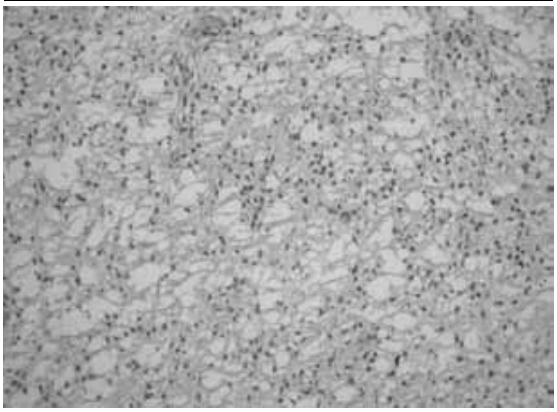
figurE 2 – Pilocytic astrocytoma exhibiting spongy, microcystic area. HE, 100× HE: hematoxylin and eosin.